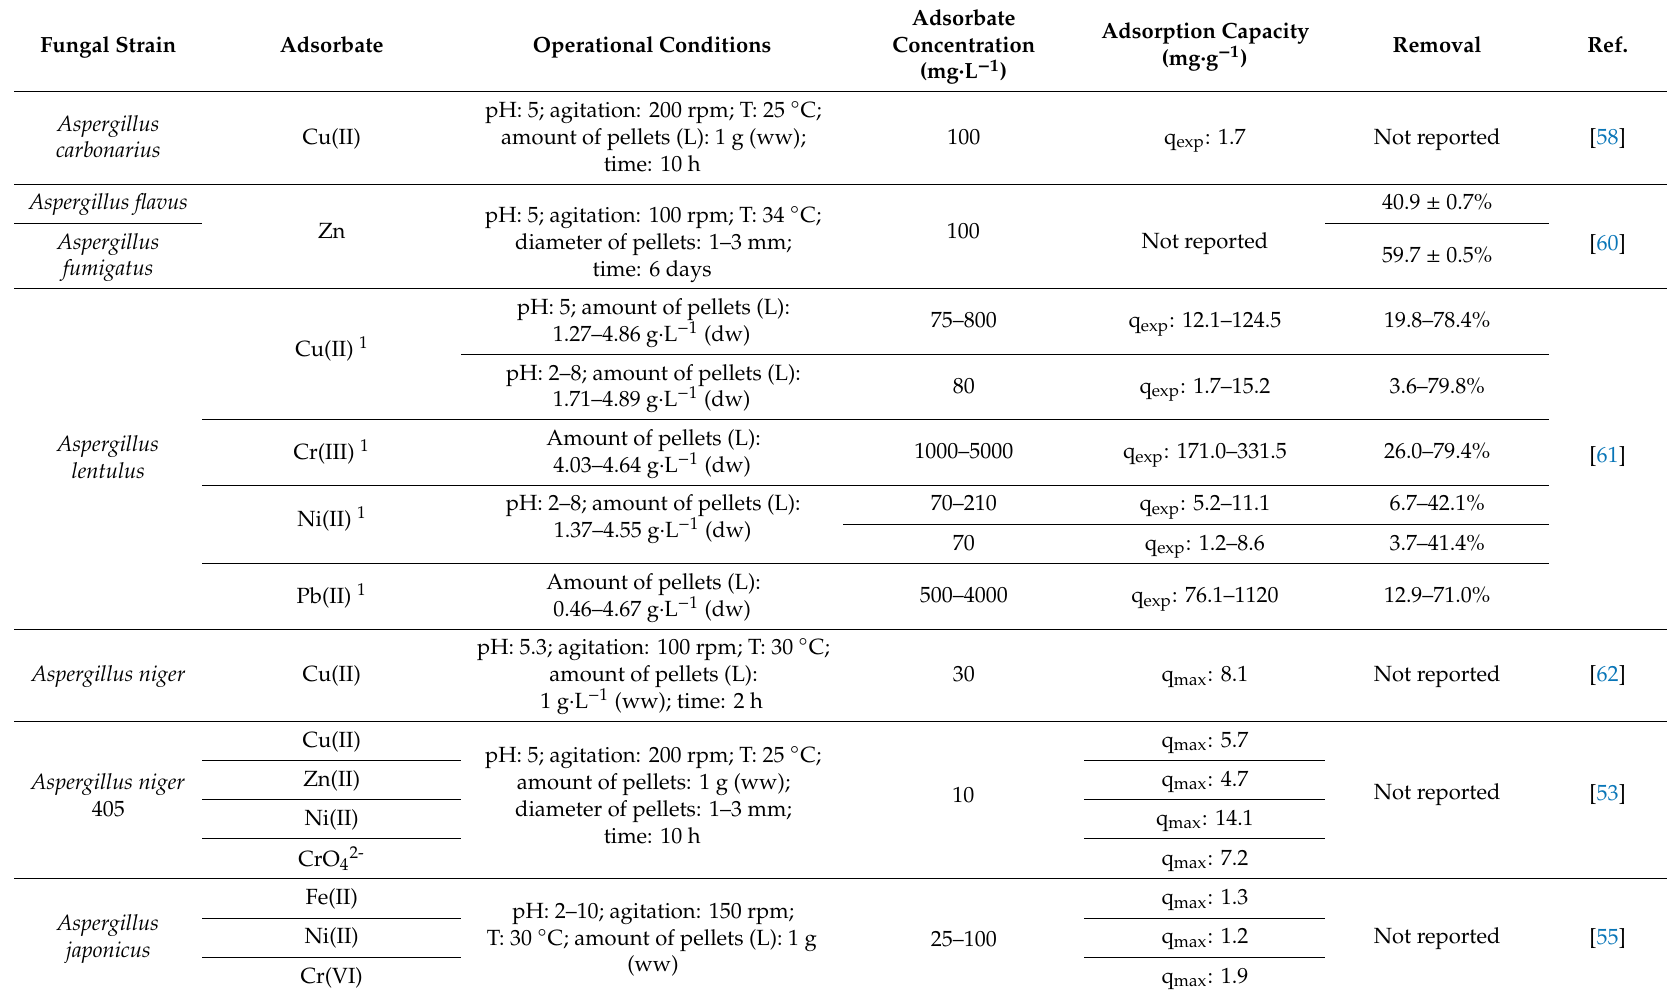
Table 1. Biosorption of heavy metals by fungal